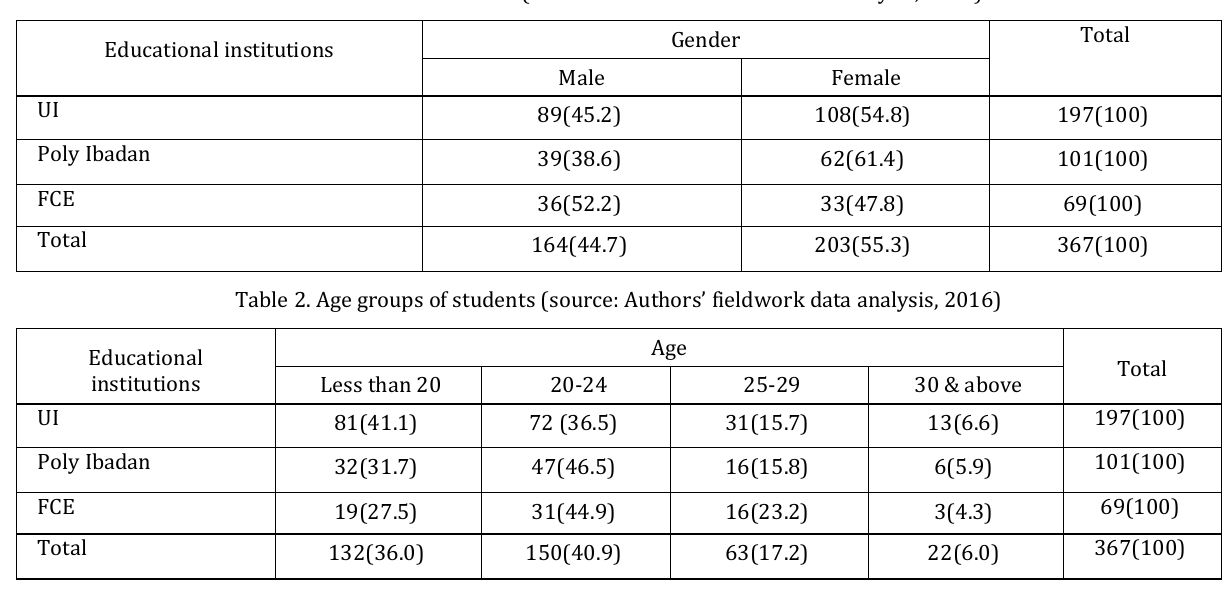
Table 1. Gender of students (source: Authors’ fieldwork data analysis, 2016)